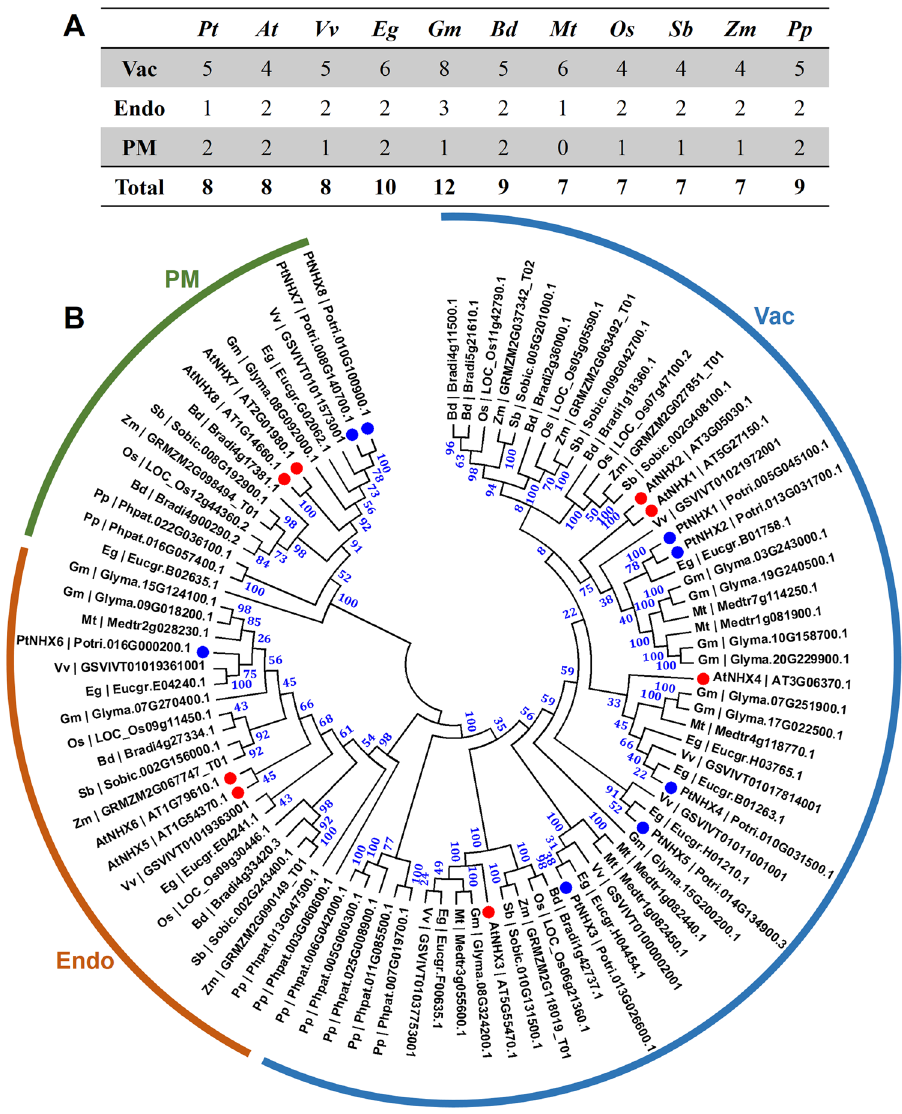
( Mt ), B. distachyon ( Bd ), O. sativa ( Os ), S. bicolor ( Sb ), Z. mays ( Zm ), and P. patens ( Pp ). ( B ) Phylogenetic tree was constructed using the maximum likelihood (ML) method with 1,000 bootstrap replicates. The three major classes (Vac-, Endo-, and PM-) are marked with different colors. Details of NHXs from 11 plant species was listed in Supplementary Table